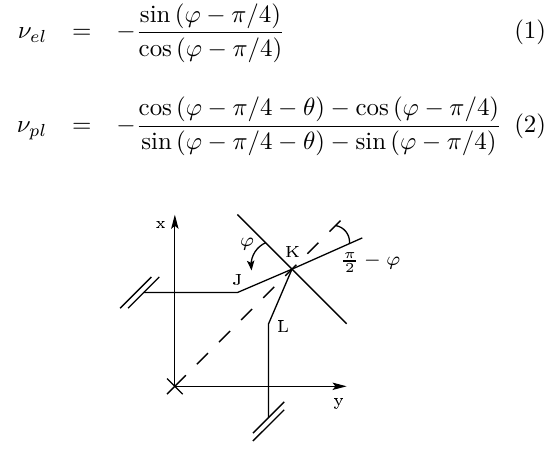
Figure 2. One quater of cross section of the re-etrant tetrakaidecahedral unit cell